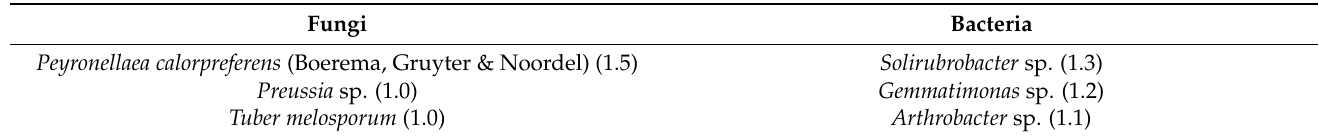
Table 2. Cont . Fungi Bacteria Peyronellaea calorpreferens (Boerema, Gruyter & Noordel) (1.5) Solirubrobacter sp. (1.3) Preussia sp. (1.0) Gemmatimonas sp. (1.2) Tuber melosporum (1.0)